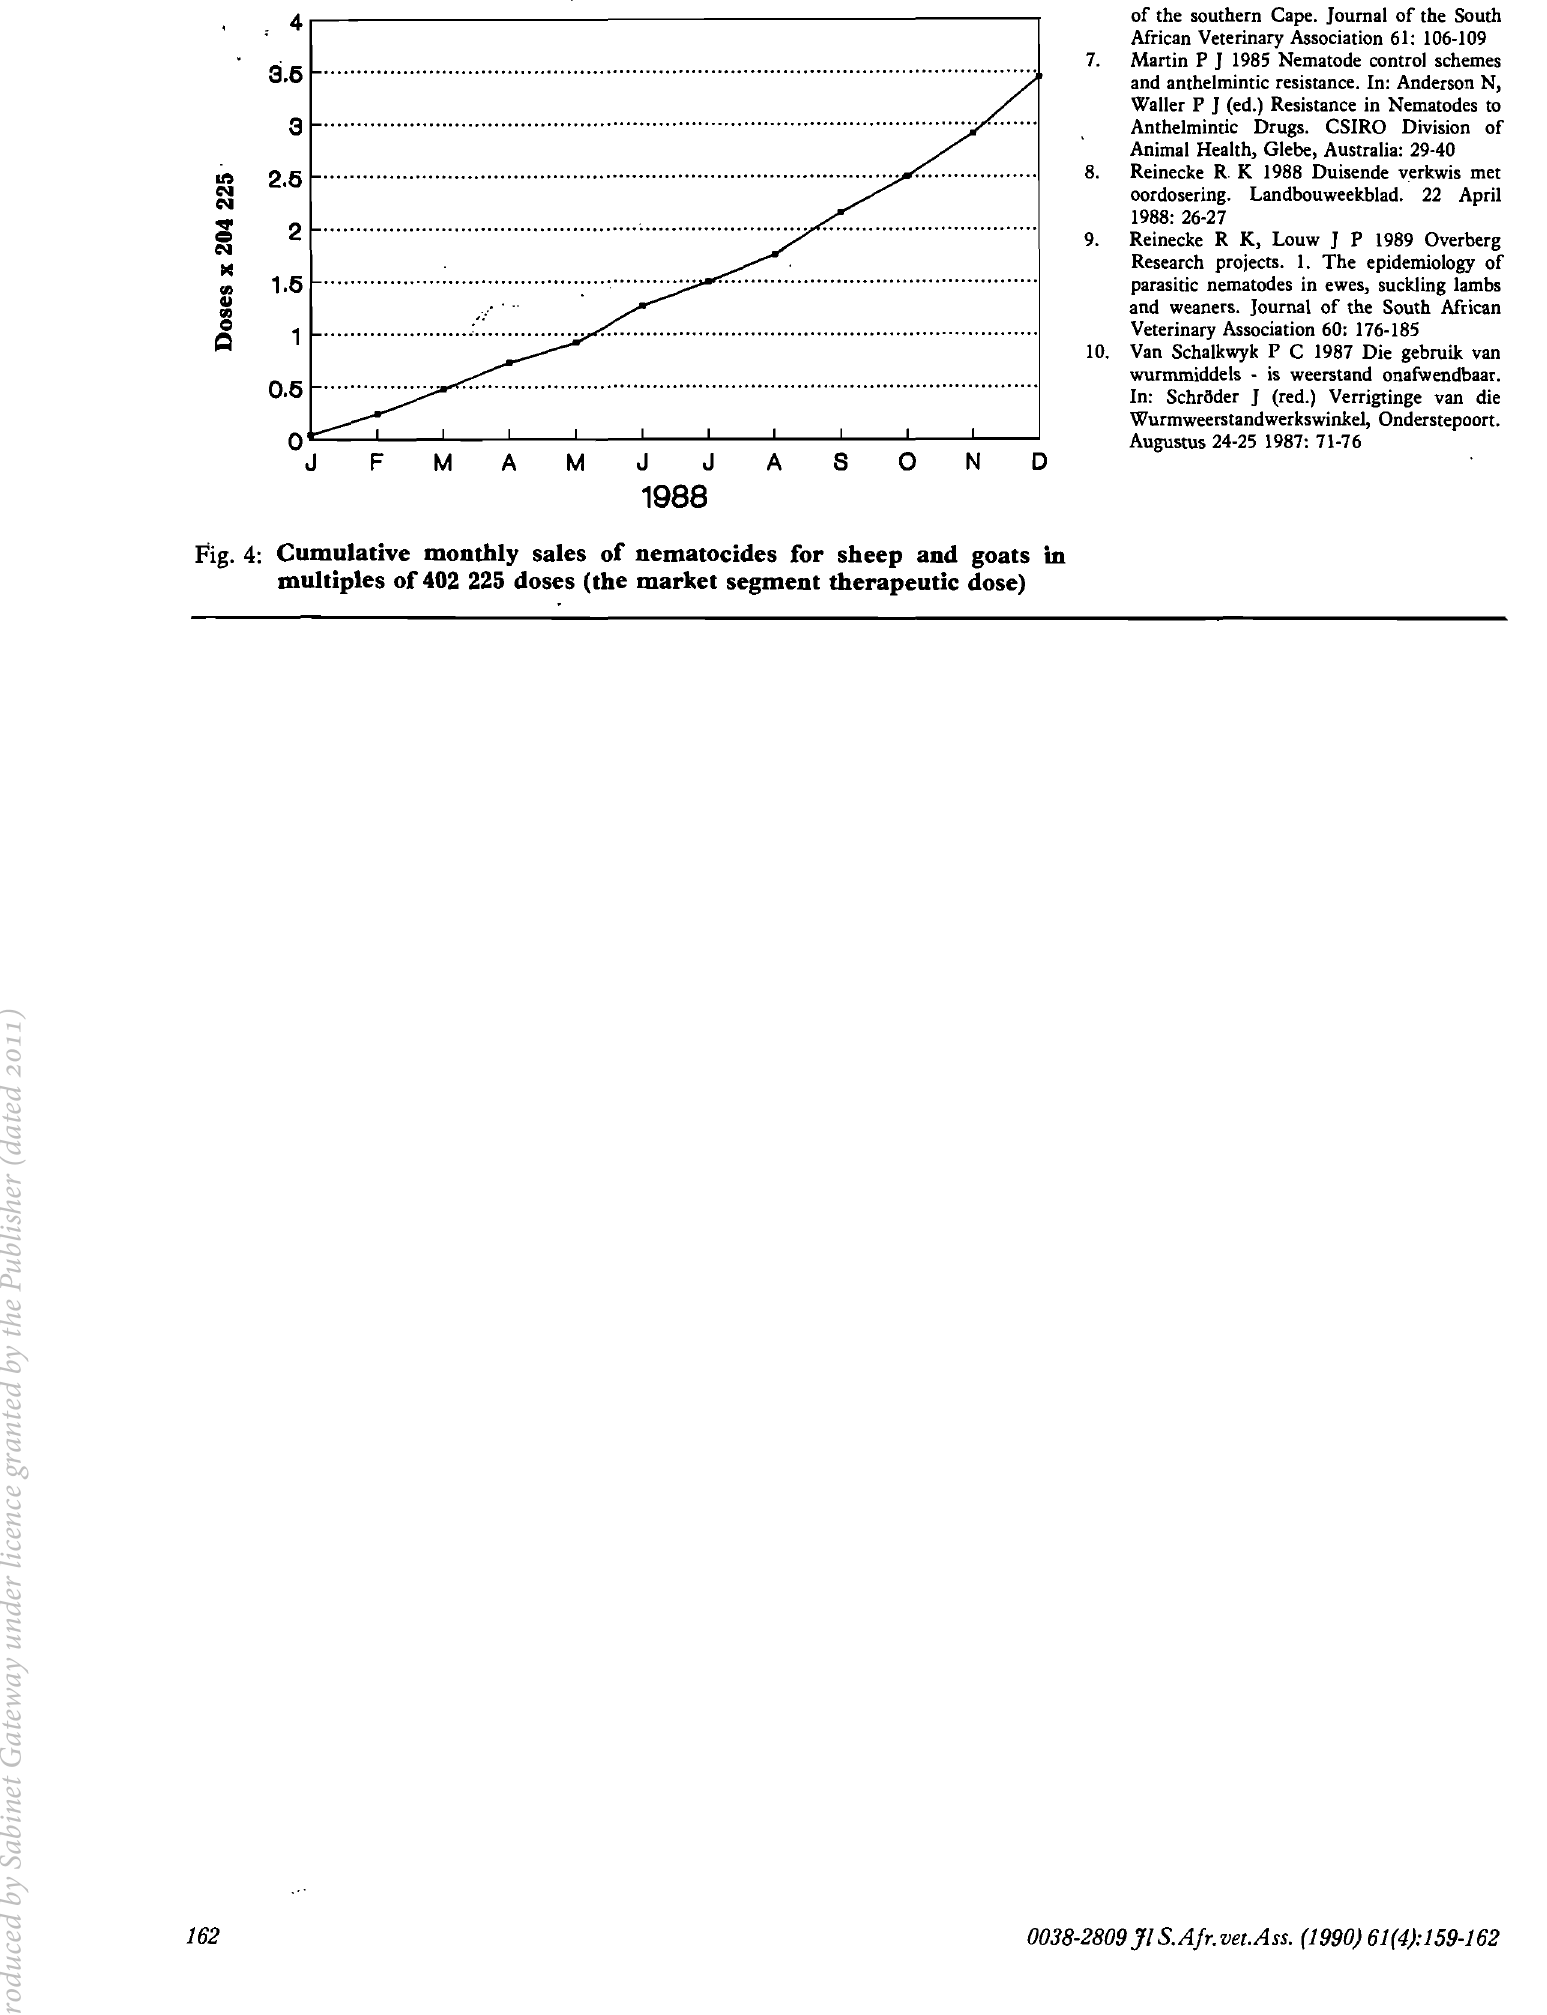
Fig. 4: Cumulative monthly sales of nematocides for sheep and goats in multiples of 402225 doses (the market segment therapeutic